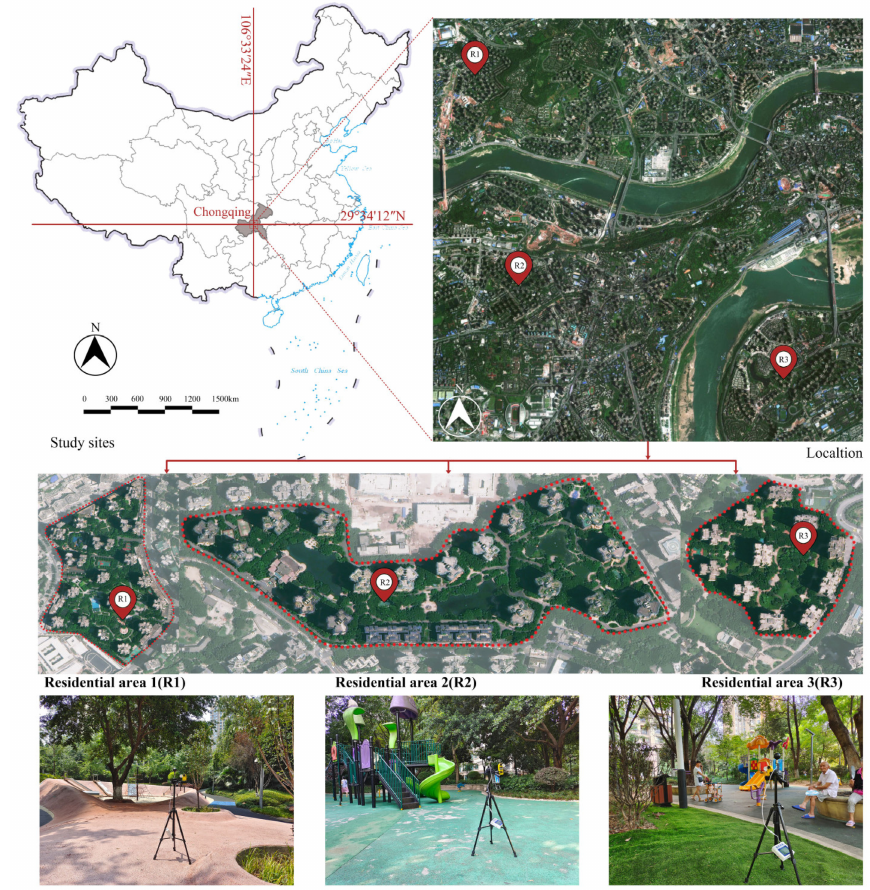
Figure 1. Site locations and measured